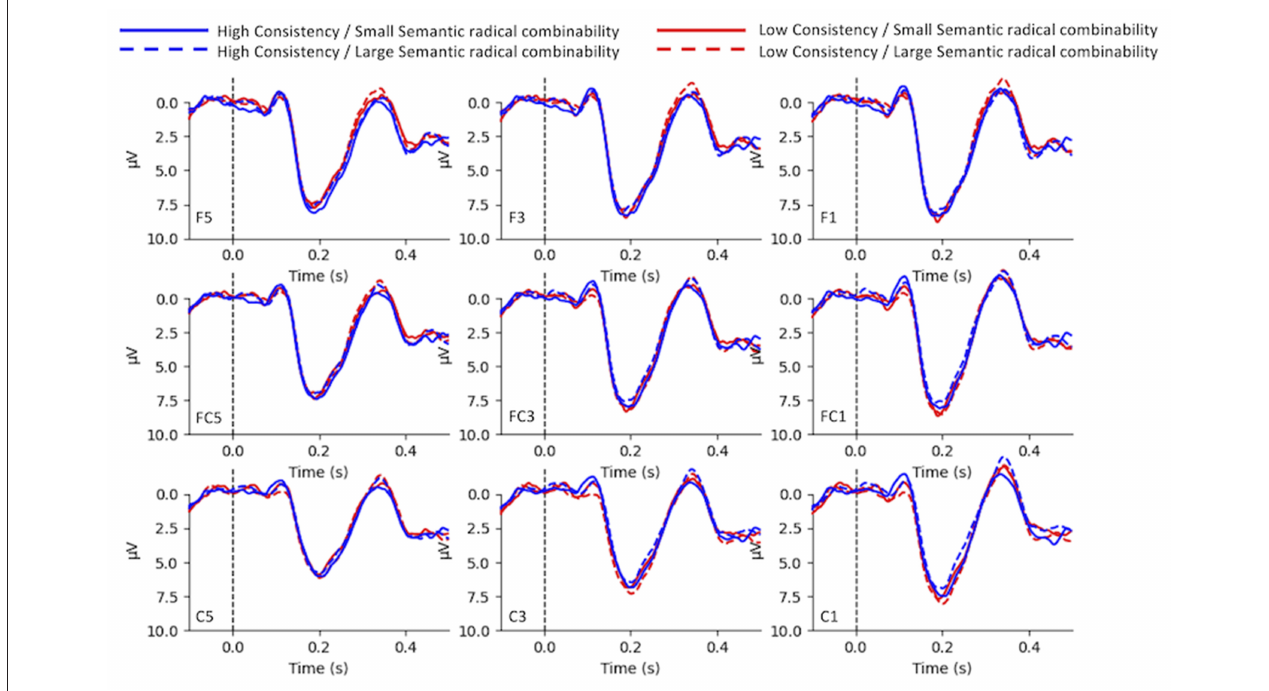
FIGURE 4 | The grand-average waves of